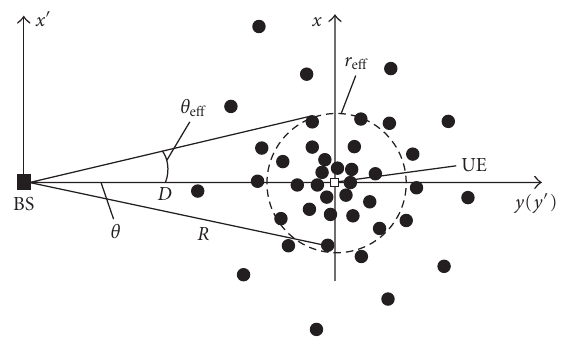
Figure 1: Illustration of the Gaussian channel